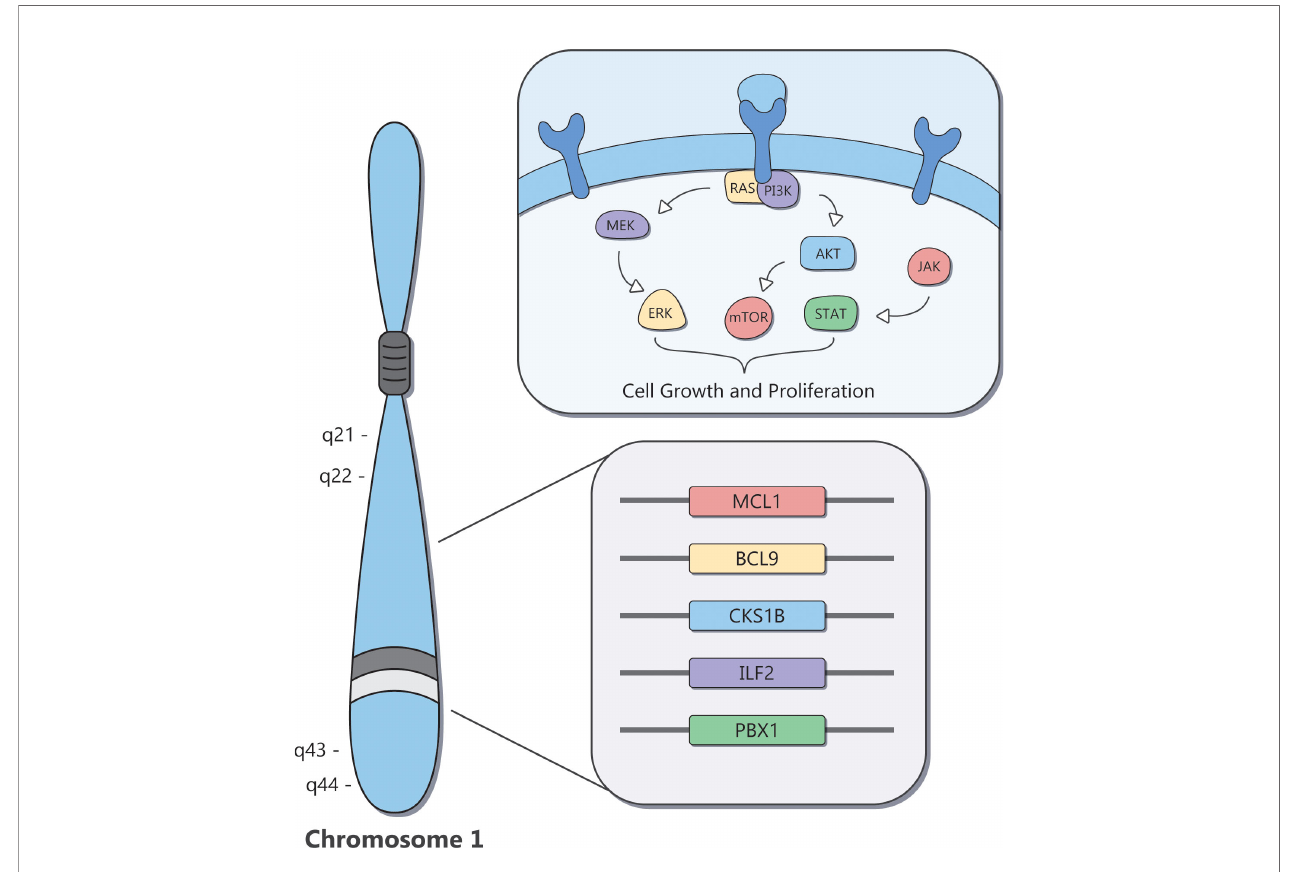
FIGURE 3 | Overview of the therapeutic vulnerabilities of MM with